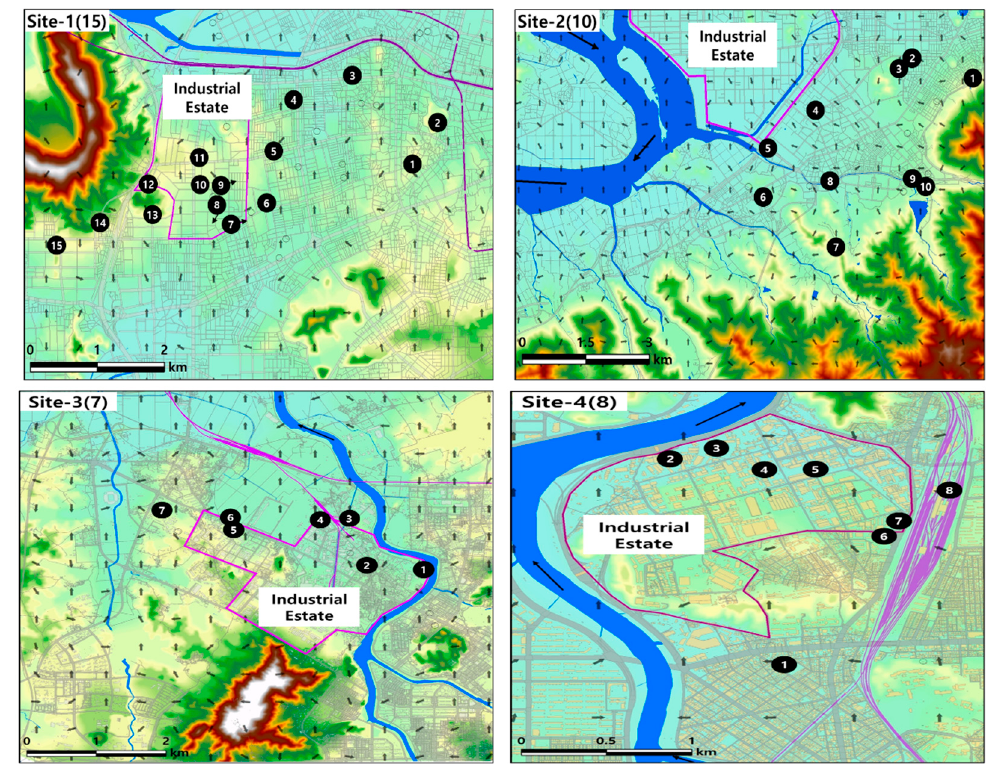
Figure 1. Locations of detailed monitoring wells.